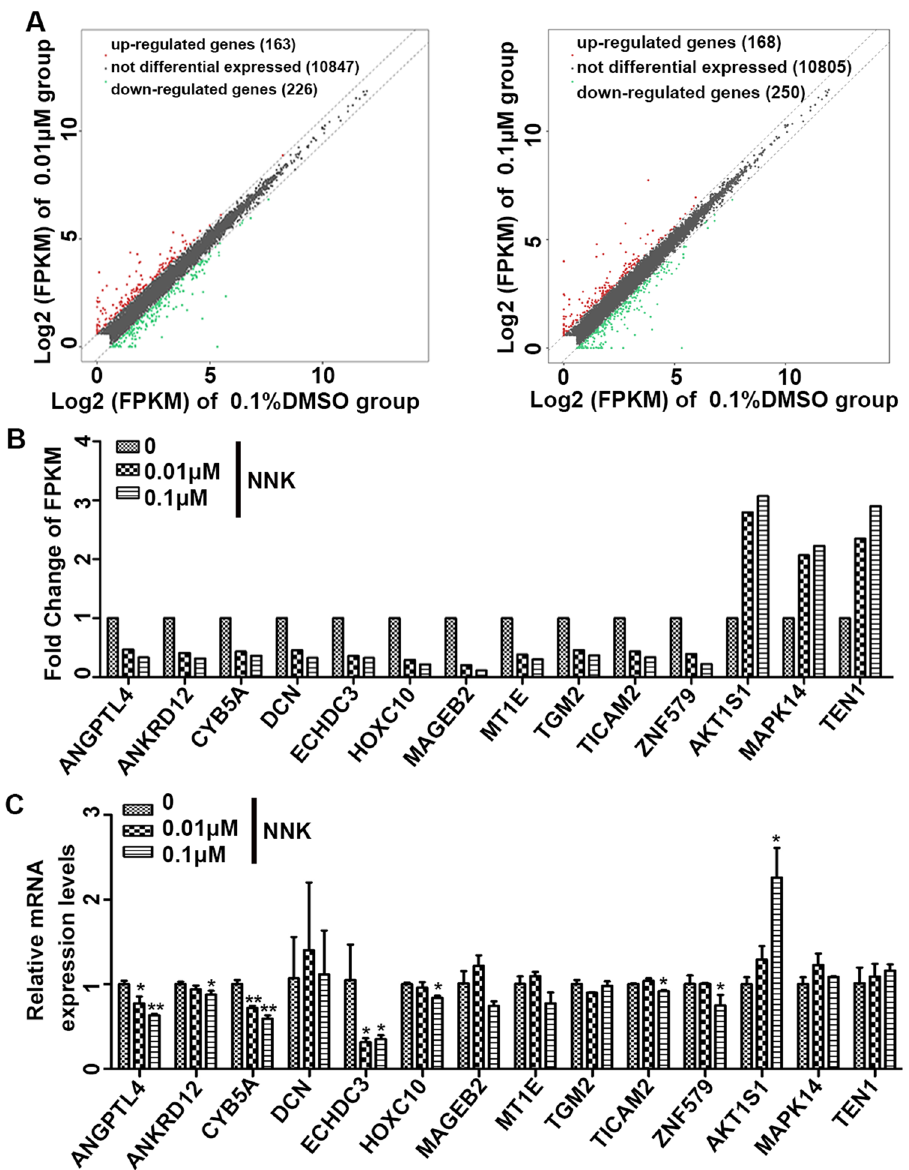
Figure 2. Identification of Cigarette Smoke Exposure-related Genes in RCC Cell. ( A ) The volcano plots of differentially expressed genes of 786-O cells exposed to 0 (0.1% DMSO), 0.01, 0.1 μM NNK at passage 40. ( B ) Identification of fourteen hub differentially expressed cigarette smoke exposure-related genes. ( C ) Real-time PCR validated the mRNA expression levels of fourteen hub differentially expressed cigarette smoke exposure- related genes in 786-O cells exposed to 0 (0.1% DMSO), 0.01, 0.1 μM NNK at passage 40. Data were presented as means ± standard deviations * P < 0.05, ** P <